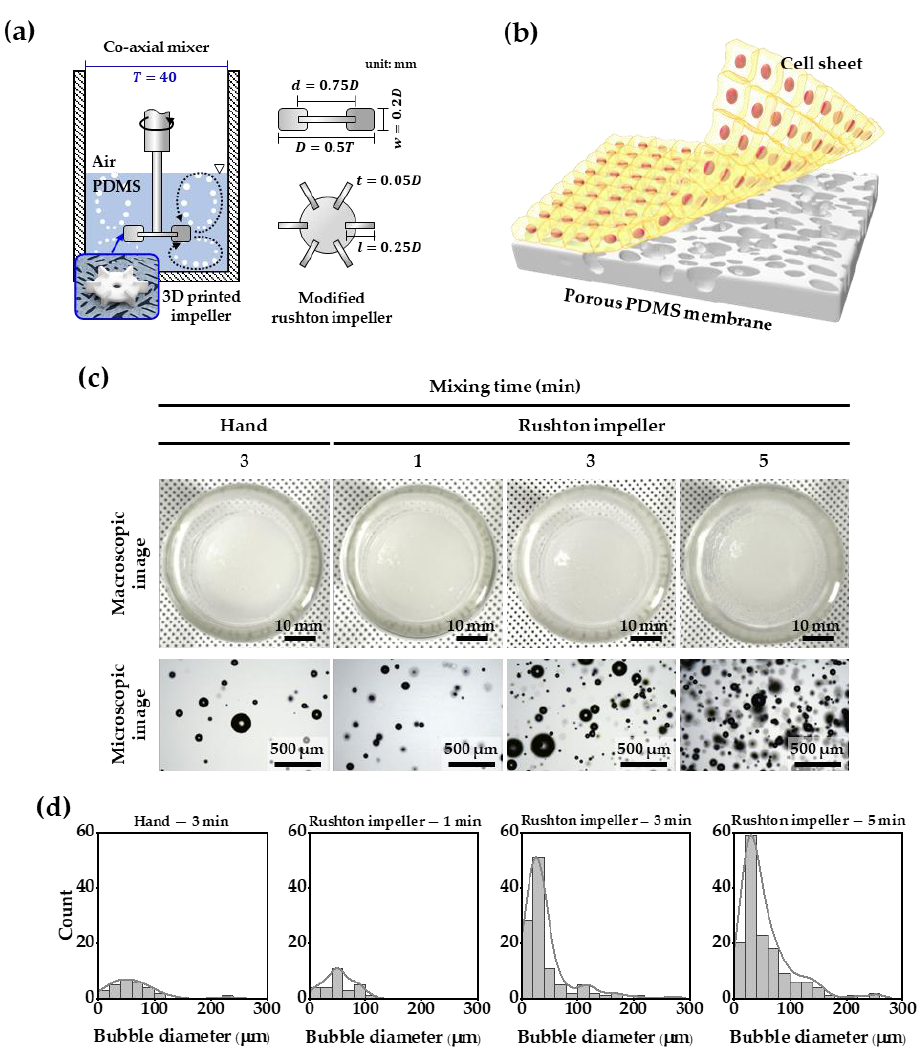
Figure 1. ( a ) Schematic illustration of the Rushton impeller mounted on a co-axial mixer, ( b ) sche- matic of cell sheet on porous PDMS membrane, ( c ) macroscopic and microscopic images of bubbles generated by hand and Rushton mixing, and ( d ) quantitative measurement of microbubbles in PDMS solution. PDMS